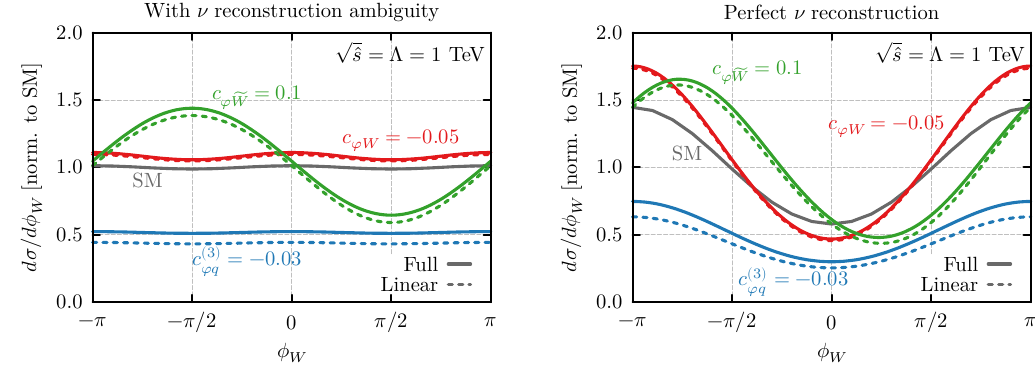
p Figure 3 . Distributions in the azimuthal angle of the W , ^ s = 1 TeV and integrated over (cid:18) and (cid:18) W . Gray lines correspond to the SM distribution, blue to c (3) ’q = (cid:0) 0 : 03, red to c ’ w = (cid:0) 0 : 05, and green to c = 0 : 1. Dotted lines do not include the squared BSM terms, whereas solid lines ’ e w correspond to the full amplitude. Left: distribution taking into account the ambiguity in the neutrino reconstruction ( (cid:30) W ! (cid:25) (cid:0) (cid:30) W ). Right: distribution with perfect neutrino reconstruction. Note that the values of the Wilson coe(cid:14)cients here were chosen to make the (cid:12)gure legible and are not necessarily within the bounds reported